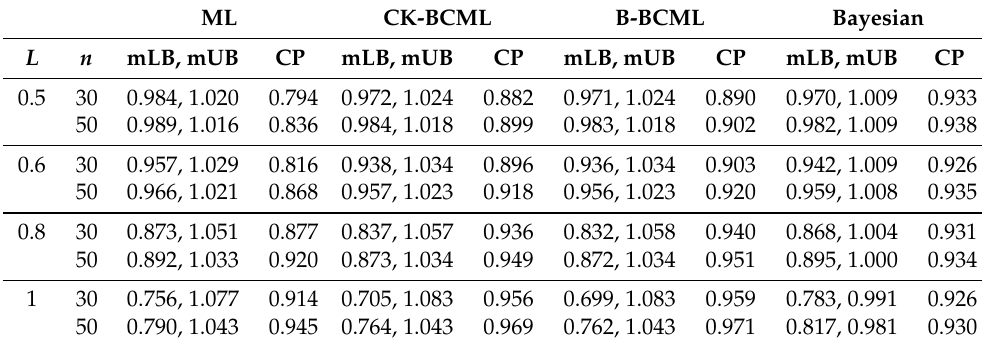
Table 4. The mLBs, mUBs and CPs for the 95% ACI and HDPI when µ = 8 and λ = 5.